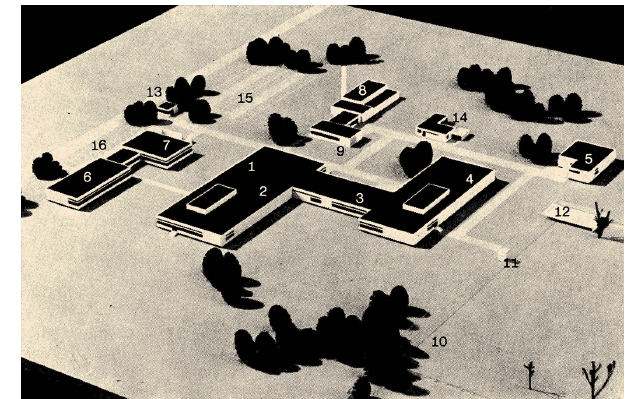
Figure 2. The first draft of the German Primate Center was de- signed by the Hanoverian architect Wilhelm-Heinrich Schrader in 1968, who was motivated to do so by his research expedition to the USA (picture from DPZ